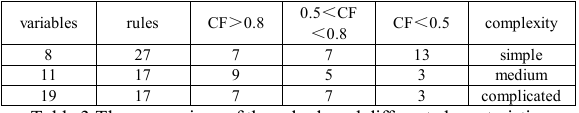
Table 3.The comparison of the rules based different characteristics